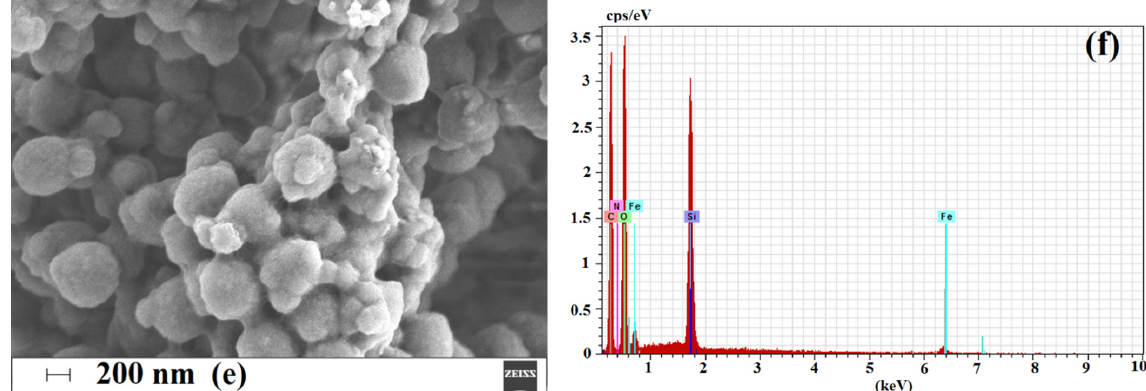
Figure 5. Micrographs of Fe 3 O 4 ( a ), Fe 3 O 4 @SiO 2 -MPS ( c ) and mag-MIP ( e ) and EDS spectra of Fe 3 O 4 ( b ), Fe 3 O 4 @SiO 2 -MPS ( d ) and mag-MIP ( f ).